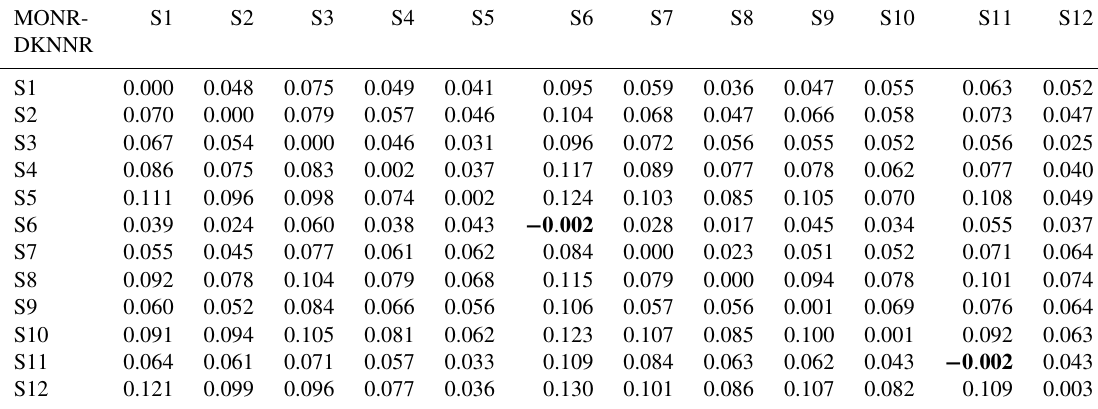
Table 8. The difference of RMSE of lag-1 cross-correlation between MONR and DKNNR. Note that a positive value indicates that the DKNNR model performs better in preserving lag-1 cross-correlation, while a negative value (in bold font) shows that the MONR model performs better.